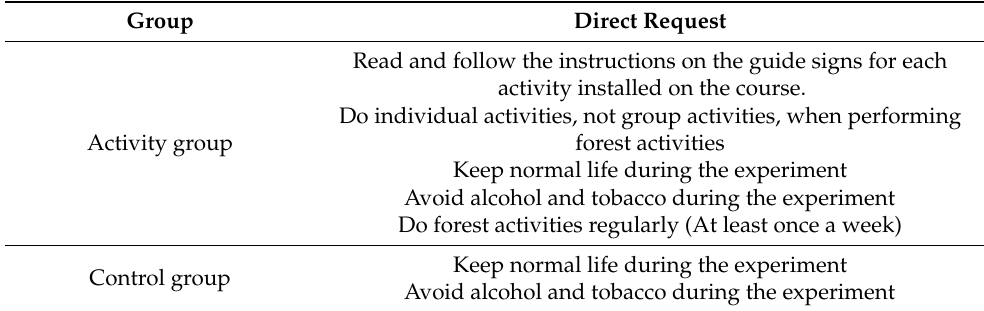
Table 1. Instructions given to the two groups of participants during the study period. Group Direct Request Read and follow the instructions on the guide signs for each activity installed on the Activity group